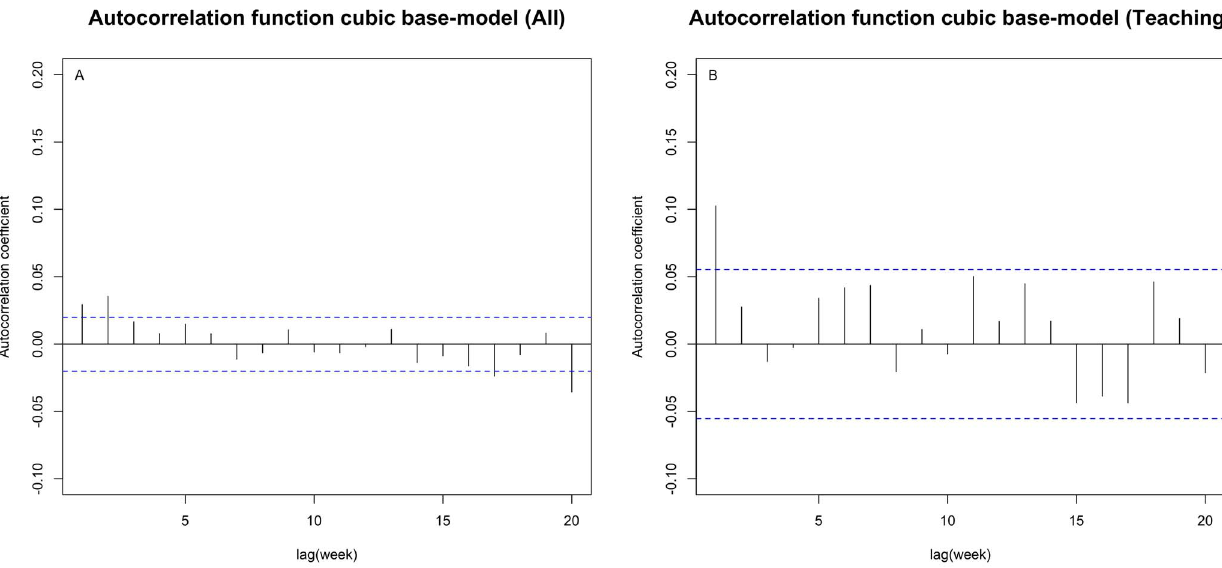
Figure 2.Dependence between observed weekly number of CDI – base-model. A and B: autocorrelation function (ACF) of normalized residuals of the base-model fitted to data of all hospitals ( A ) and of teaching hospitals only ( B ) including a fitted cubic representation of the CDI trend over time and seasonality. The blue lines correspond to the threshold for significance of correlation (dependence) (p , 0.05) between lagged weekly observations up to week 20. E.g. crossing of this threshold by the base-model residuals at lag 1 and lag 2 for the model fitted to all hospitals suggests that a correlation exists between the observed CDI in a given week and the number of CDI cases present in the hospital one and two weeks earlier. doi:10.1371/journal.pone.0099860.g002 group of teaching hospitals only, revealed a stronger, but still relatively low statistically significant correlation between CDI cases and patients present in the hospital one week later ( W = 0.104